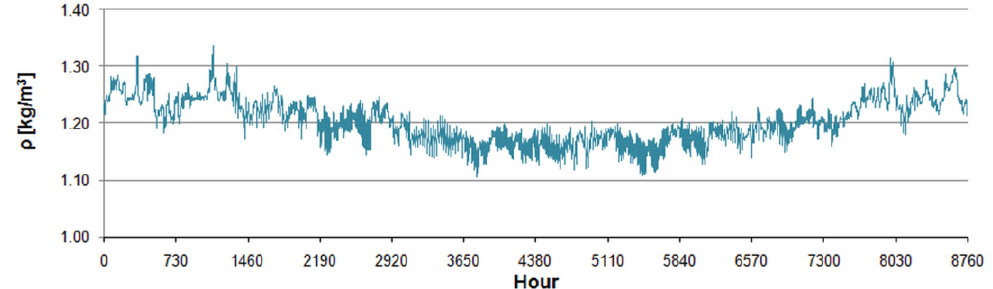
Figure 8. Calculated air density.